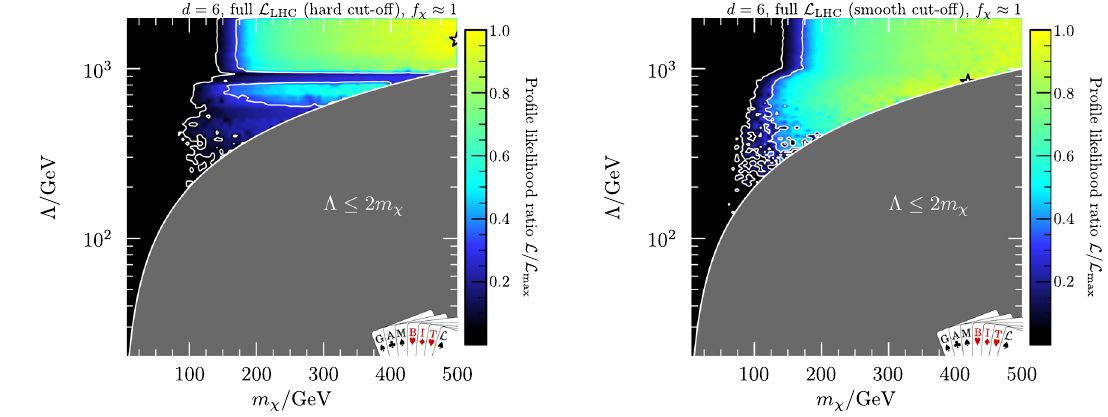
Fig. 10 Same as Fig. 8 but requiring the DM relic abundance to match the total observed DM abundance Table 5 Best-fit points from our various scans involving dimension-6 operators with restricted parameter ranges (5GeV ≤ m χ ≤ 500GeV and 20GeV ≤ (cid:2) ≤ 2TeV). For most scans, there are degeneracies between different parameters around the best-fit point. In these cases,